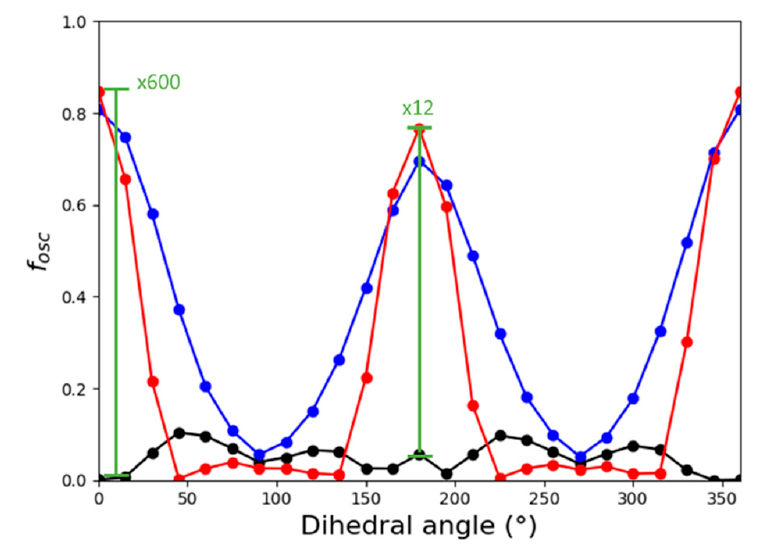
Figure 4. Oscillator strength for the S 0 → S 1 transition. Black, blue, and red colours correspond to external electric fields (EEF) = 0, +2.3 × 10 − 4 a.u. and − 2.3 × 10 − 4 a.u., respectively. Note the strength difference in the enhancement of the oscillator between trans-TMC and cis-TMC conformers (a factor of 12 and 600, respectively).